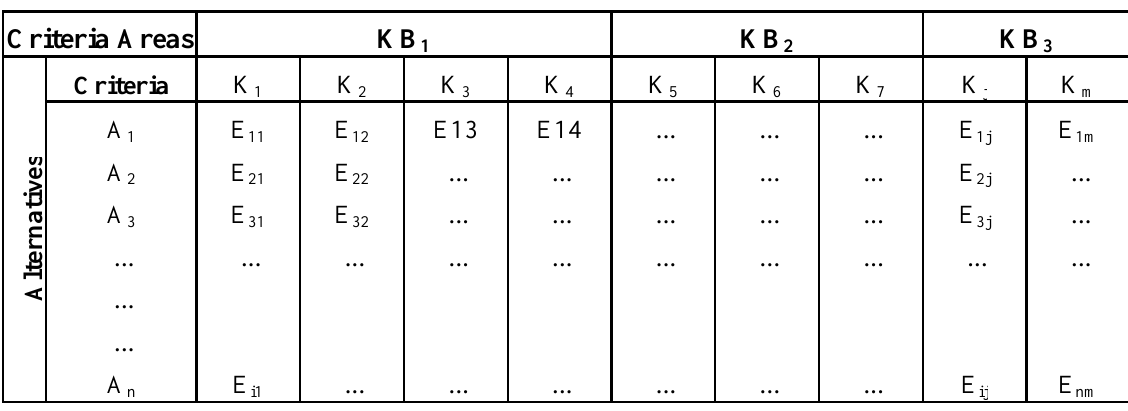
Table 1. Linear notation of a goal-data matrix